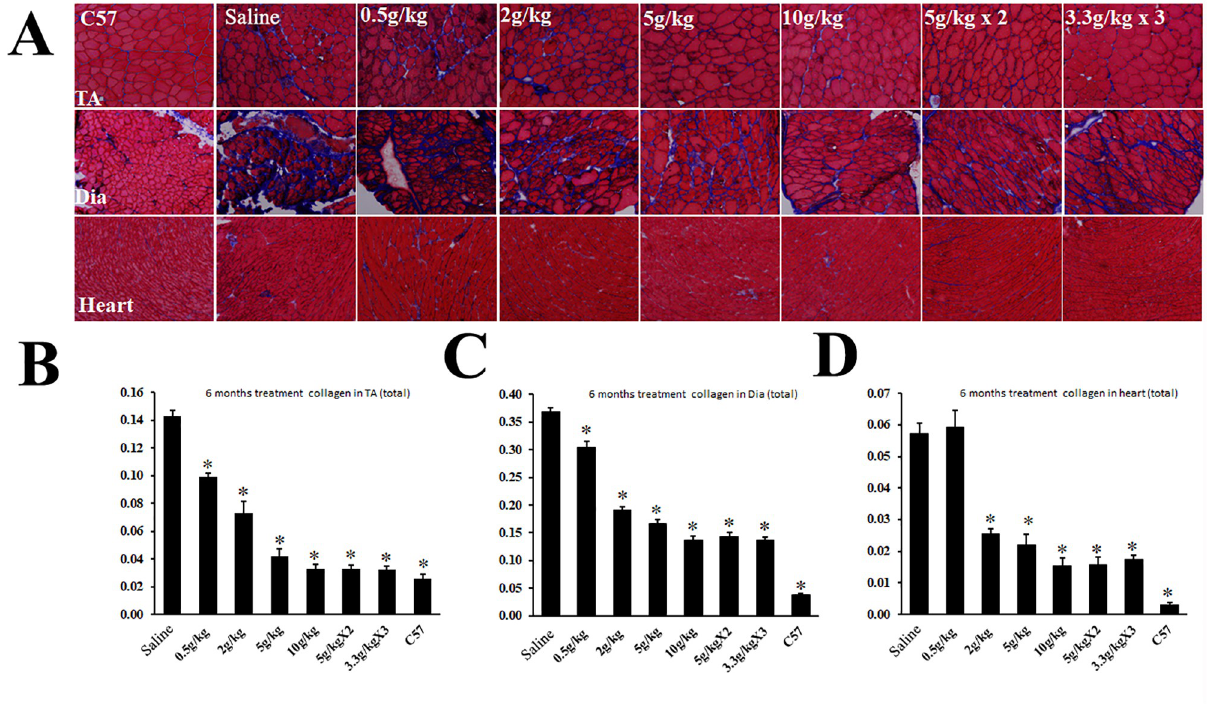
Fig 3. Masson Trichrome staining for the measurement of fibrotic areas in the 6-month ribitol-treated P448L mutant mice. (A) Microscopic image of the staining with blue color representing fibrotic areas and red color the remaining muscle fibers. (B-D) Measurement of fibrotic areas with NIH ImageJ. Y axis represents percentage of fibrotic area within the total section area (1 equals to 100% of area measured). � P < 0 . 05 n = 5 when compared with saline-treated control.